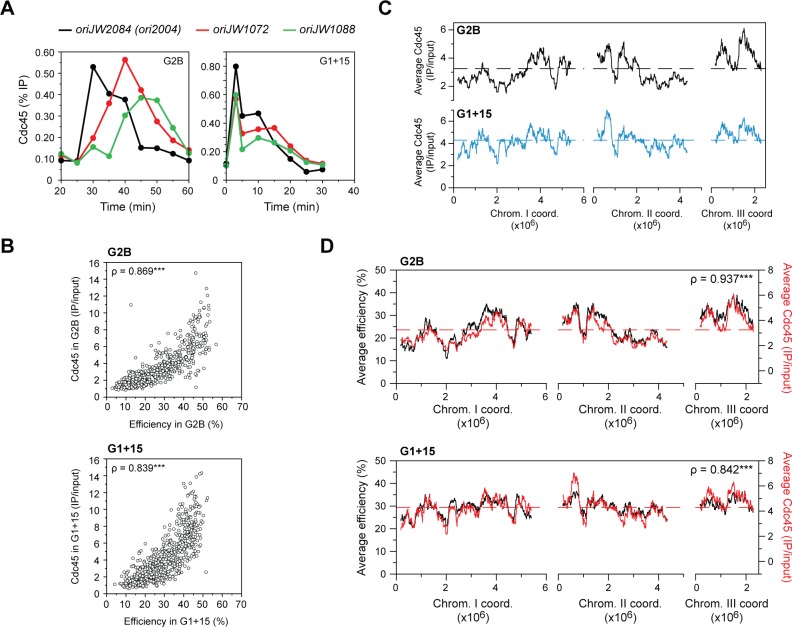
G1 extension results in a redistribution of Cdc45 binding.A) Time courses of chromatin immunoprecipitation of Cdc45 in the G2B (left panel) and G1+15 (right panel) conditions (see Figs 1A and 2A for the experimental procedures). Note that these experiments were performed in the absence of HU to allow progression through S phase. Efficiencies of the origins analyzed are as follows: in G2B, oriJW2084 (ori2004): 45%, oriJW1072: 21%, oriJW1088: 21%; in G1+15, oriJW2084 (ori2004): 38%, oriJW1072: 29%, oriJW1088: 36%. x-axis: time after release from G1 arrest; y-axis: % IP. n = 2, a representative experiment is displayed. B) Comparison of Cdc45 recruitment with origin efficiency at each origin. Top panel: G2B; bottom panel: G1+15. Detailed genome-wide profiles of Cdc45 binding are displayed in S3 Fig. We observe a strong correlation between Cdc45 occupancy levels and origin efficiencies in both conditions. x-axis: origin efficiencies; y-axis: Cdc45 binding. Each circle represents an origin. The Spearman’s rank correlation coefficients (ρ) are displayed. ***: p-value < 0.001. C) Regional profiles of Cdc45 recruitment in G2B (black) and G1+15 (blue). The averages of Cdc45 binding at origins were determined for continuous windows of ~250 kb (1000 probes) across the genome. x-axis: chromosome coordinates, y-axis: average Cdc45 binding (IP/input). Dashed lines indicate the average Cdc45 level at all origins in each condition. D) Comparisons of the regional profiles of origin efficiency (black, left y-axis; profiles as in Fig 2F) and Cdc45 binding (red, right y-axis; profiles as in C) in G2B (top panel) and G1+15 (bottom panel). The Spearman’s rank correlation coefficients (ρ) comparing the profiles of origin usage vs. Cdc45 binding are indicated and reveal very strong positive correlations ***: p-value < 0.001. Dashed lines for genome-wide average Cdc45 levels are as in C.